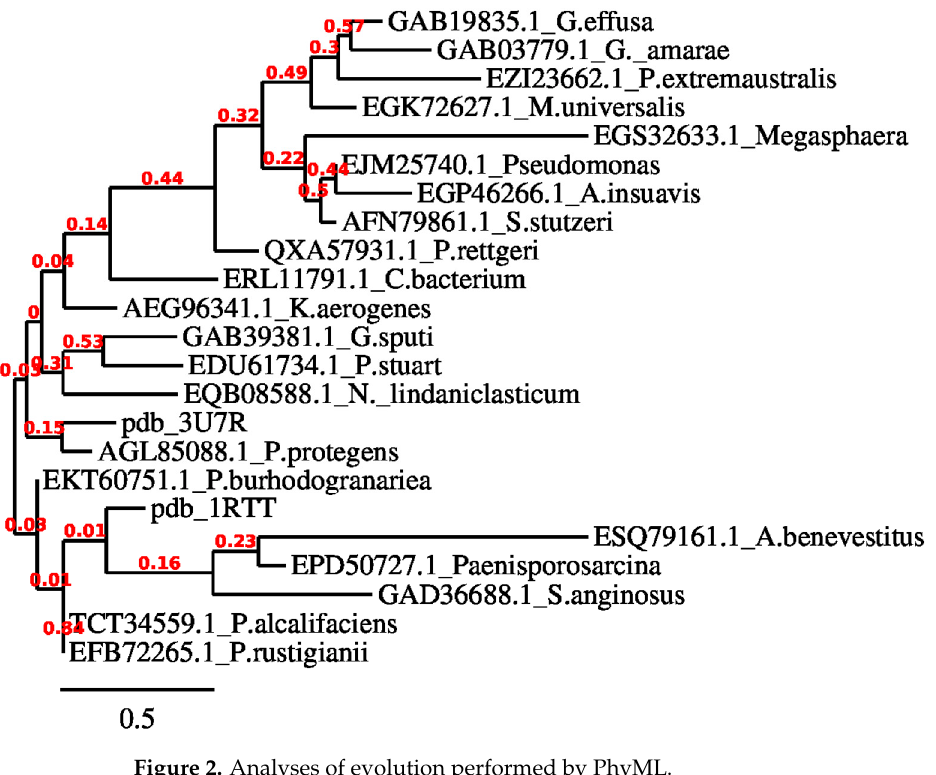
Figure 2. Analyses of evolution performed by PhyML.